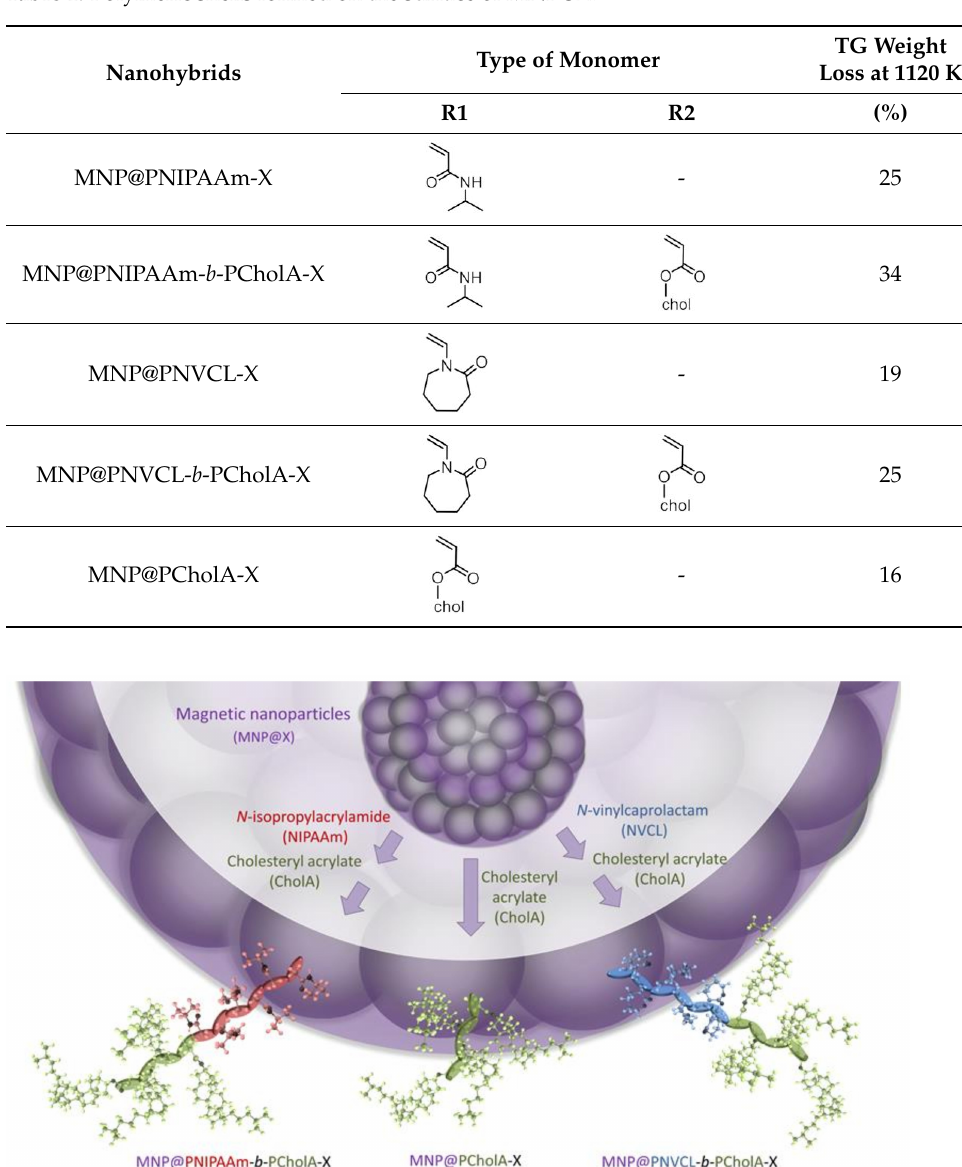
Table 1. Polymeric shells formed on the surface of MNP@X.